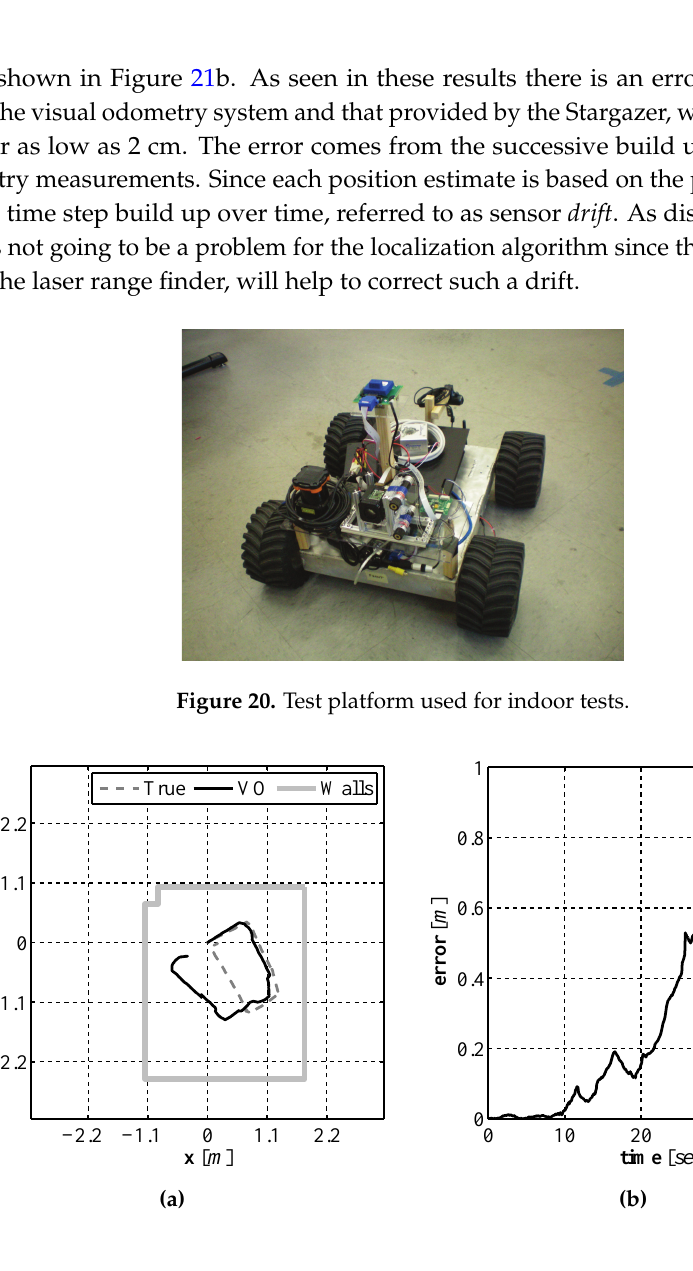
Figure 21. Visual odometry path estimate ( a ) and the error in the estimate as a function of time ( b